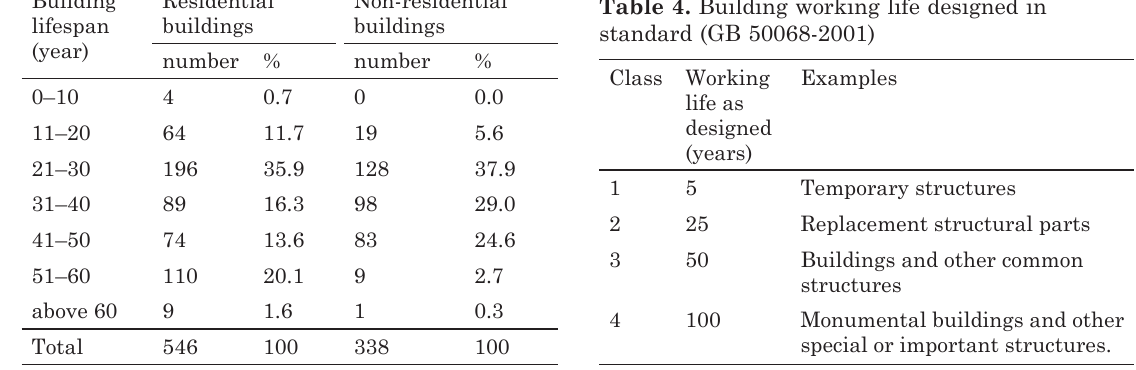
Table 4. Building working life designed